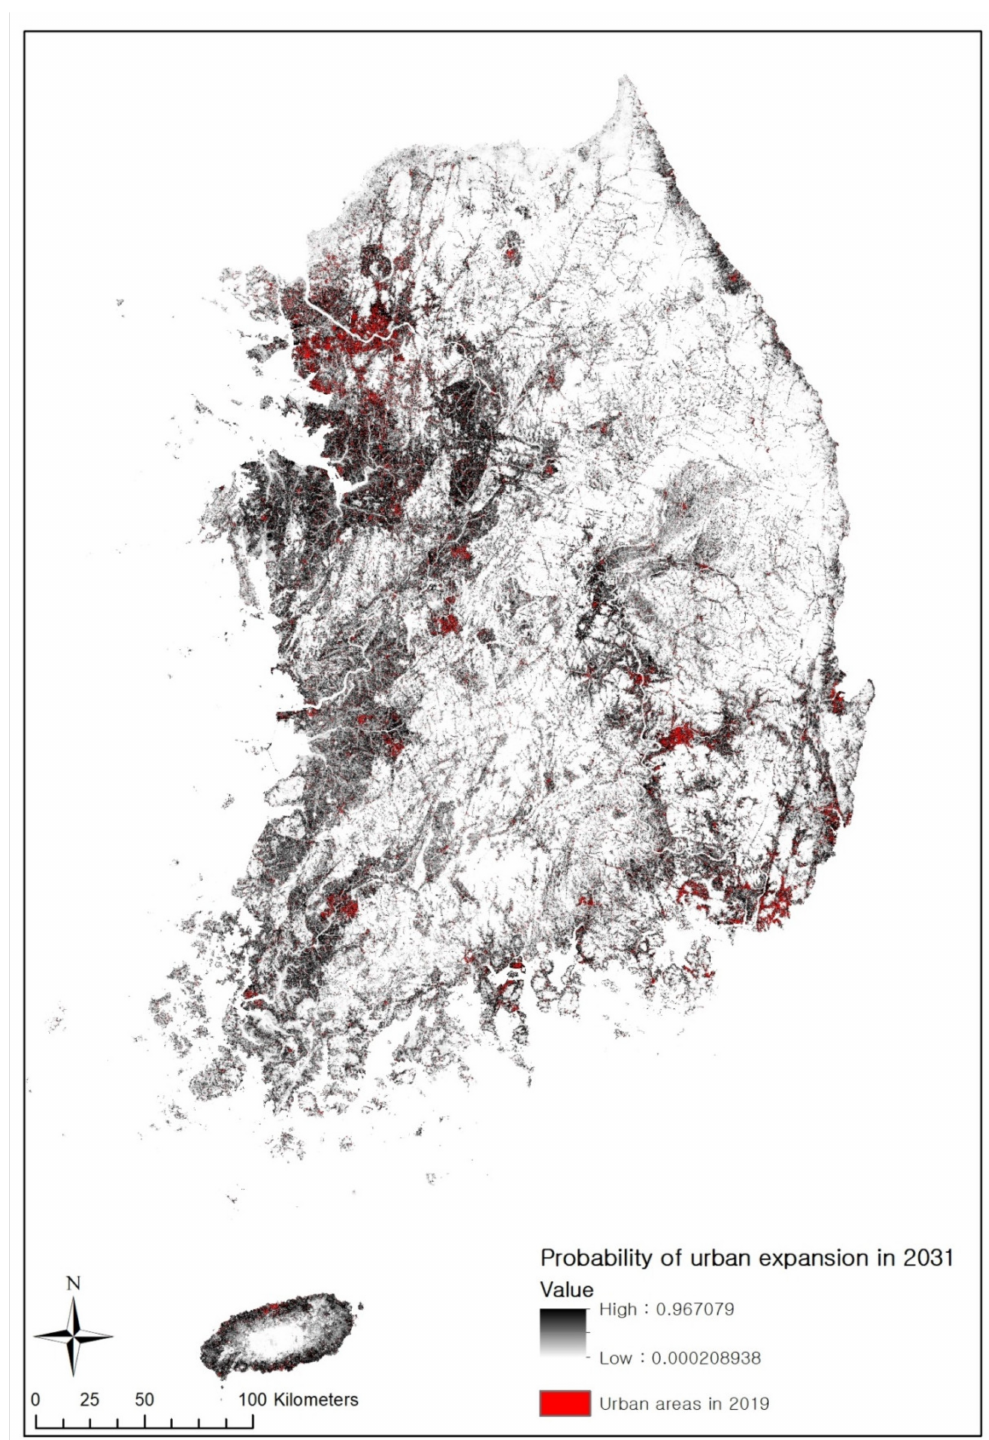
Figure 5. Probability map of urban expansion in South Korea